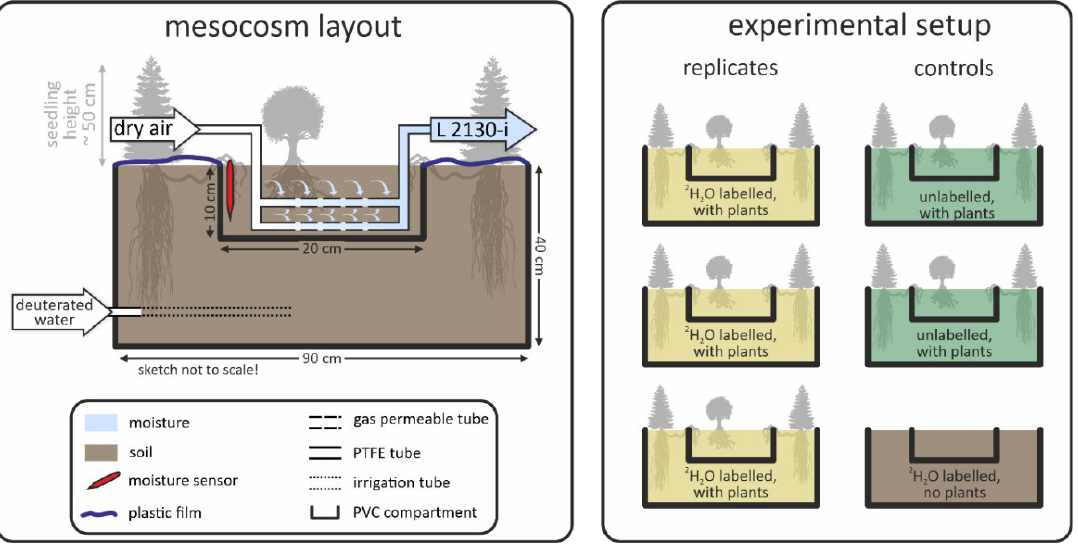
Figure 1. Experiment mesocosms. Two fir and 1 beech saplings were planted in polyvinylchloride (PVC) compartments, whereas a beech sapling was isolated within a smaller compartment in the center. A root strand of each fir was redirected into the beech compartment. Soil moisture was extracted via di ff usion into dry air passing through gas-permeable tubing connected to a water isotope analyser (Picarro L 2130-i). Experiment comprised 6 such mesocosms; 3 were used as replicates and 3 as controls (see main text for more detail).